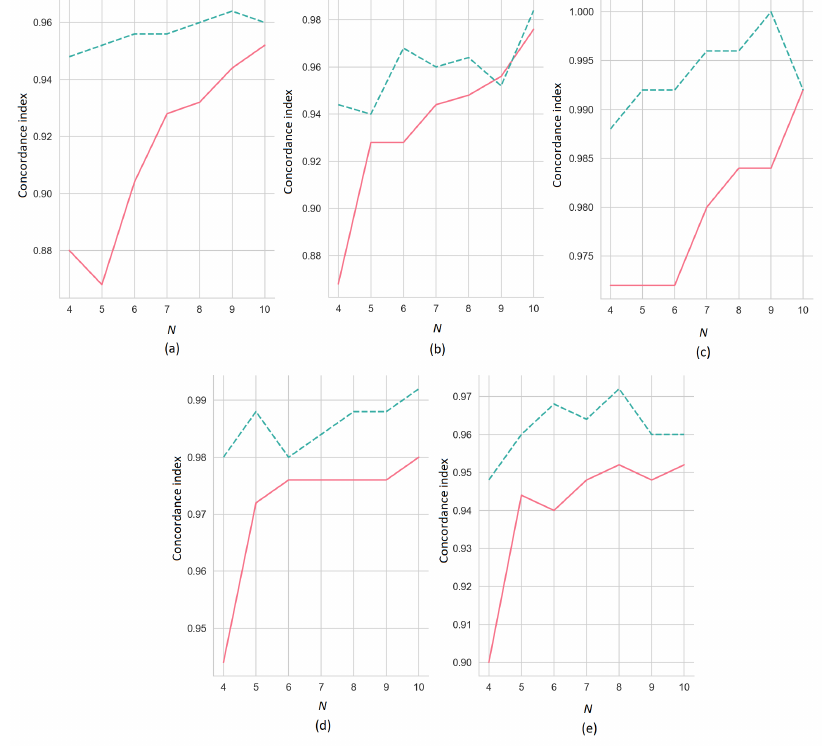
Figure 12. Concordance indices of ER-SHAP-RF as functions of N for t = 2 (the solid line) and 3 (the dashed line) for five datasets depicted in corresponding Figure 4a–e and trained SVMs